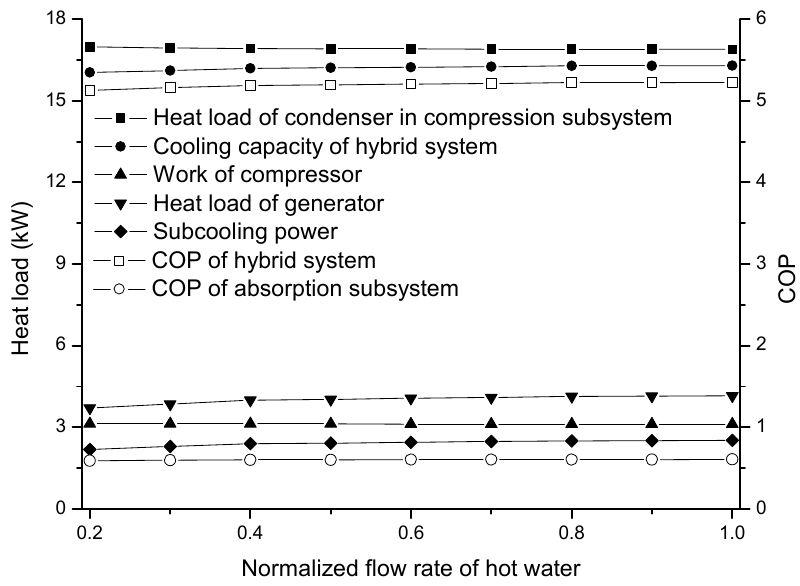
Figure 9. Performance with the flow rate of hot water.